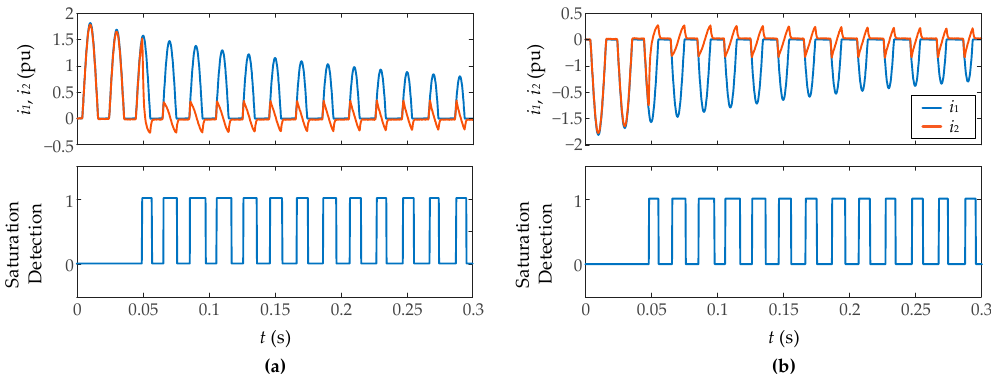
Sensors 2023 , 23 , x FOR PEER REVIEW